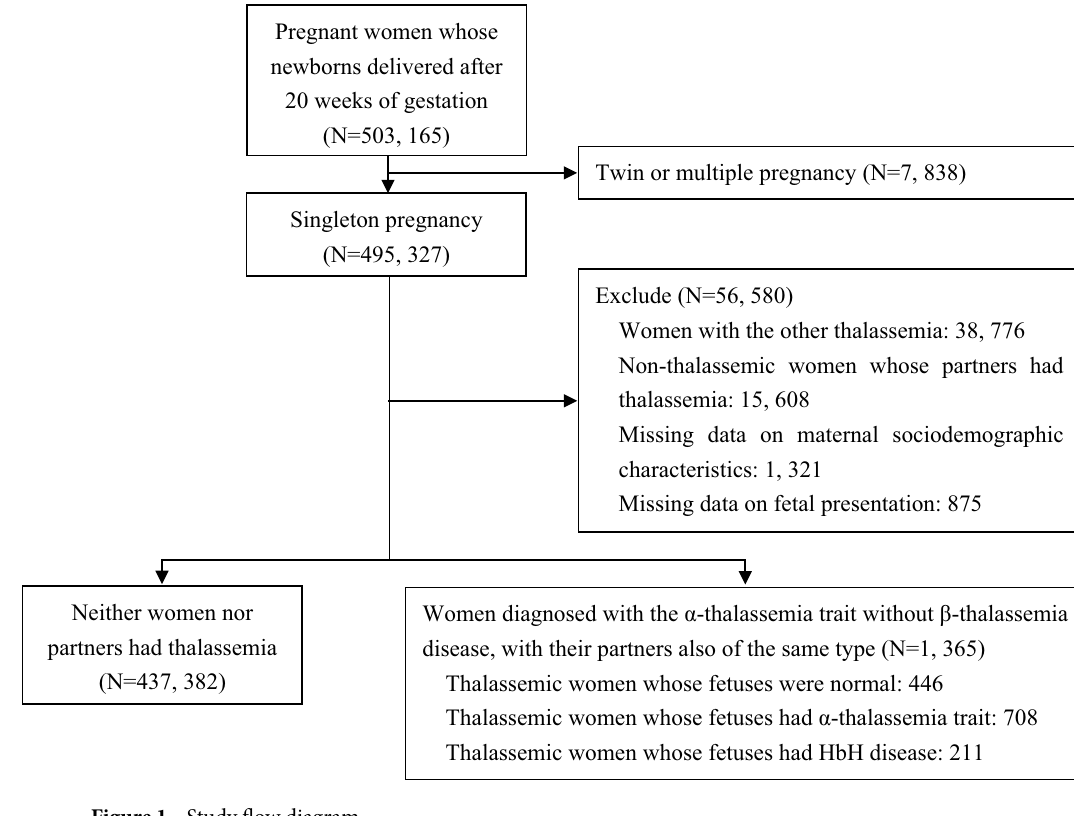
Figure 1. Study flow